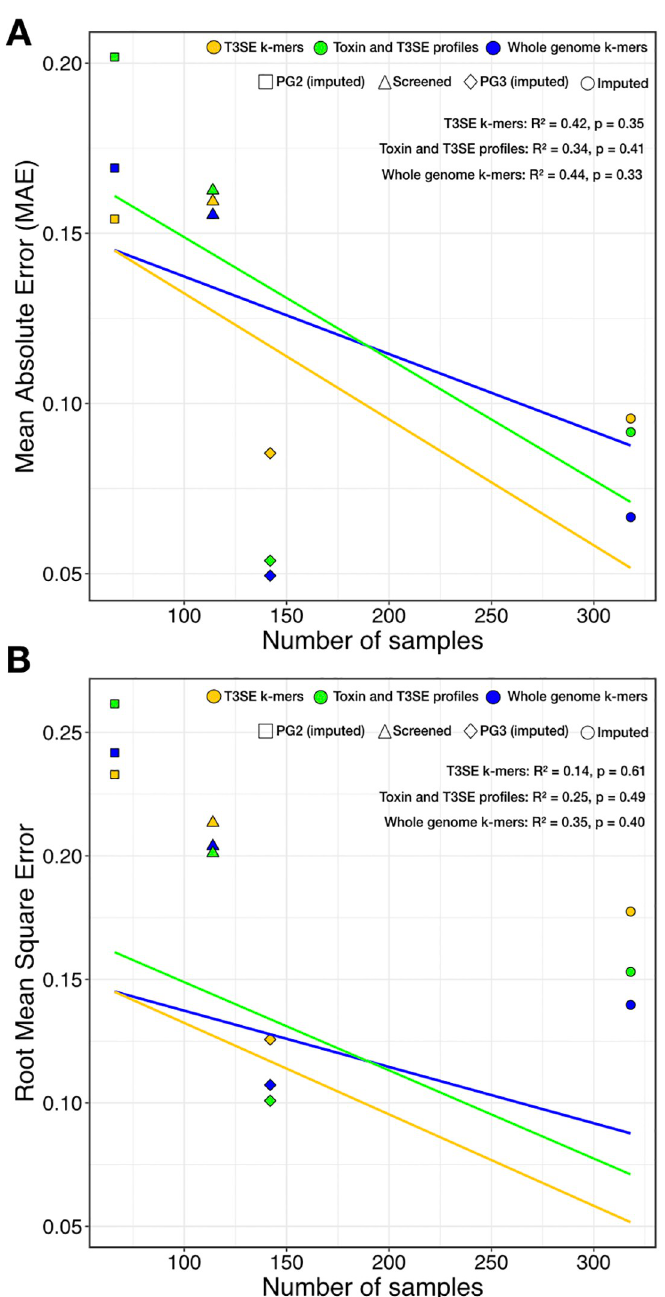
Fig 8. Performance of supervised machine learning models on virulence predictions with genome data. Shapes represent models trained with the screened collection (triangles), imputed expanded collection (circle), imputed expanded PG2 set (square), and imputed expanded PG3 set (rhombus). Colors represent models trained with a phytotoxin and T3SE binary matrix (green), T3SE k-mers (yellow), and whole genome k-mers (blue). (A) Mean Absolute Error (MAE) as a function of number of samples across 50 cross-validation splits. (B) Root Mean Square Error (RMSE) as a function of number of samples across 50 cross-validation splits.